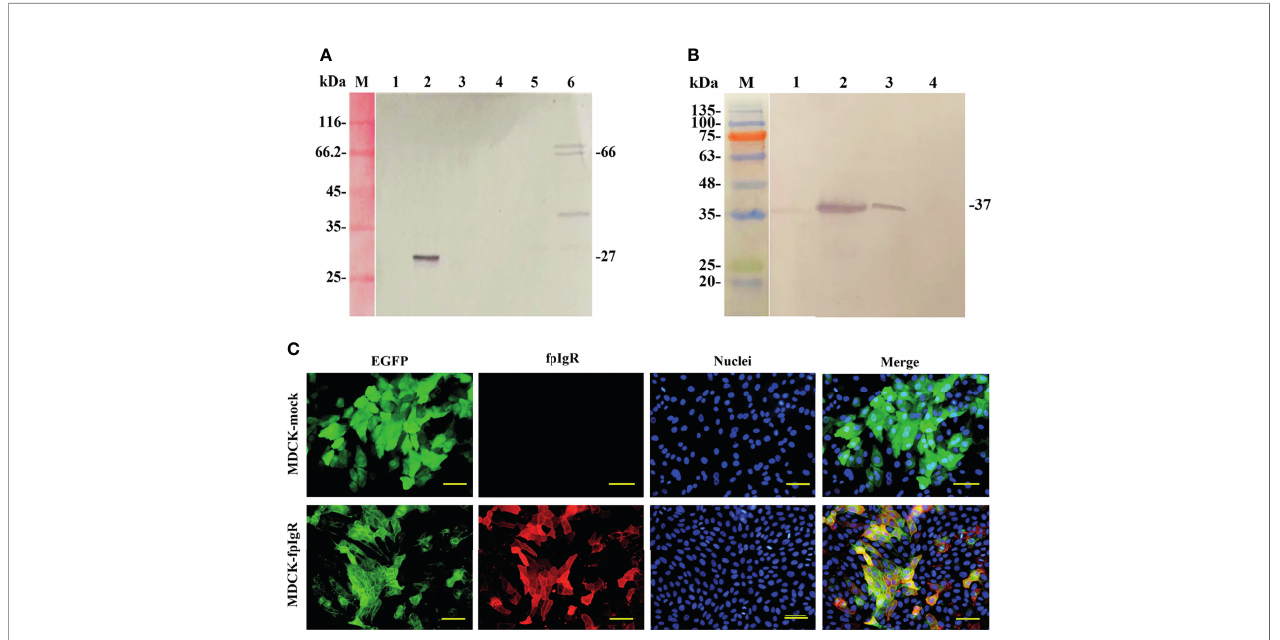
FIGURE 6 | Veri fi cation of fpIgR expression in MDCK-fpIgR cells. (A) Western blotting of the cytosol and membrane proteins of MDCK cells. M: Molecular mass standards; lanes 1, 2, and 3: cytosol proteins of MDCK, MDCK-mock, and MDCK-fpIgR cells, respectively; lanes 4, 5, and 6: membrane proteins of MDCK, MDCK- mock, and MDCK-fpIgR cells, respectively. (B) Western blotting of the gut mucus of fl ounders and cell culture supernatants. M: Molecular mass standards; lane 1: gut mucus of fl ounders; lanes 2, 3, and 4: MDCK-fpIgR, fl ounder gill (FG) cell, and MDCK-mock cell culture supernatants without FBS, respectively. (C) Veri fi cation of fpIgR expression (red fl uorescence signals) in MDCK-fpIgR cells by immuno fl uorescence staining. Bar = 50